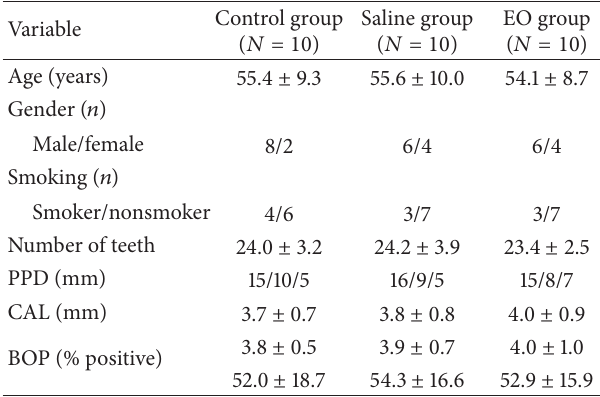
Table 1: Demographic and clinical characteristics of the study population (mean ±